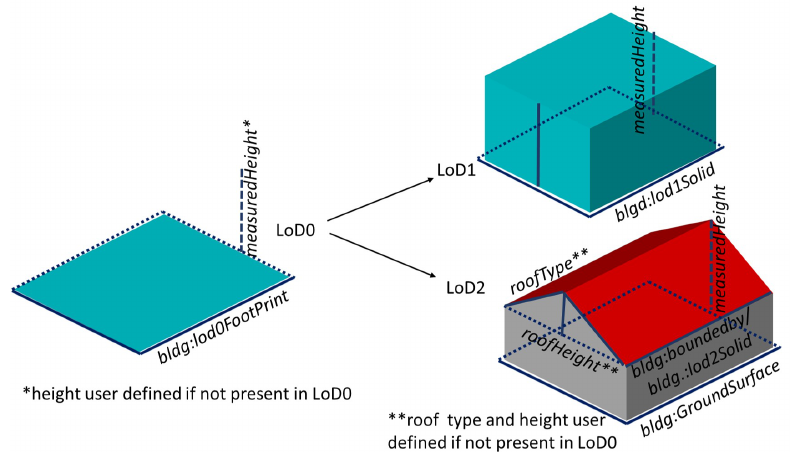
Figure 5. An overview of upscaling LoD0 models to LoD1 and